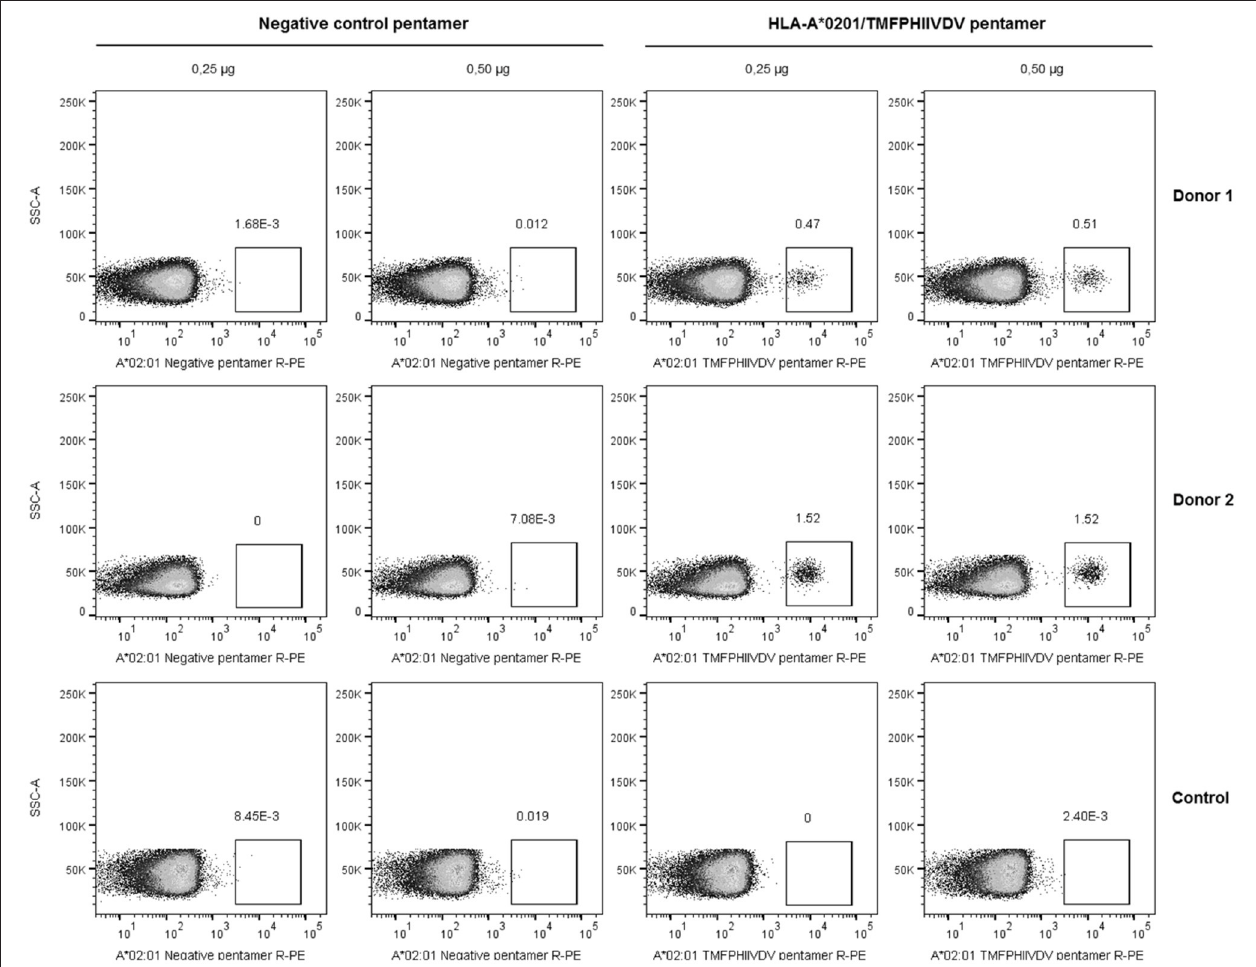
FIGURE 2 | Pentamer staining of norovirus-derived 139 TMFPHIIVDV 148 epitope-specific CD8 + T cells. Peripheral blood mononuclear cells (PBMCs) from two HLA-A*0201-positive healthy adult donors and the negative control were directly stained using 0.25 and 0.5 µ g HLA-A * 0201/TMFPHIIVDV pentamer or negative control pentamer. The dot plots show the percentage of pentamer-positive T cells for two HLA-A*0201-positive donors and a representative negative control donor after gating on live CD3 + CD8 + T lymphocyte